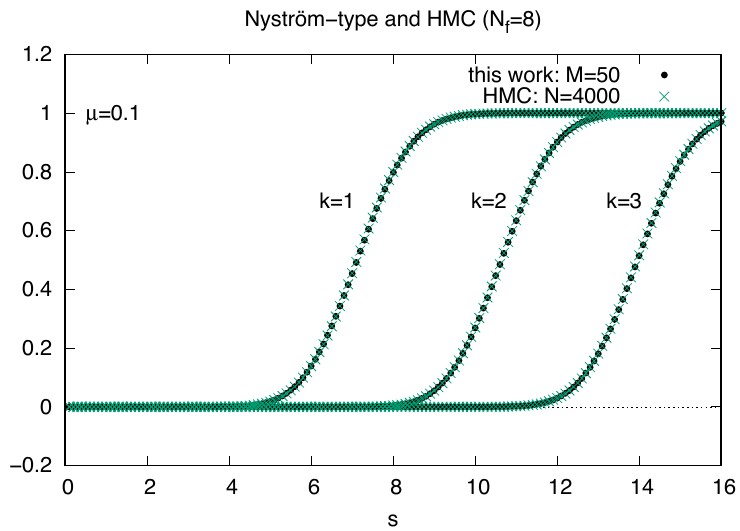
Figure 8 . Plot of F k ( s ) in 0 (cid:20) s (cid:20) 16 for N F = 8 in the complete con(cid:13)uent limit with (cid:22) 1 = 0 : 1 and the topological charge (cid:23) = 0. Black dot: Nystr(cid:127)om-type discretization of order M = 50. Green cross: hybrid Monte Carlo simulation with the random matrix rank N =